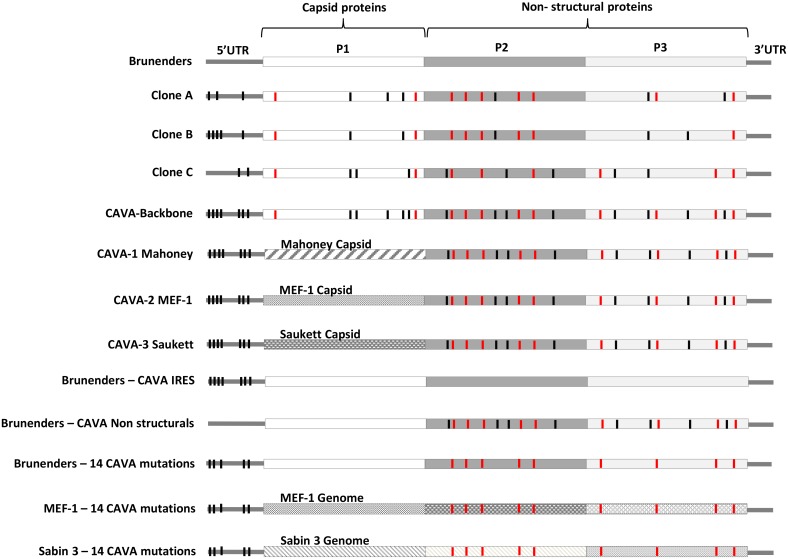
Schematic overview of the viruses described here and their incorporated mutations.Black vertical lines represent the synonymous CAVA mutations whilst red vertical lines represent non-synonymous CAVA mutations, dispersed over the poliovirus genome; a detailed description of the individual mutations is given in S1 Table. 5’UTR = 5’ Untranslated Region, 3’UTR = 3’Untranslated Region.